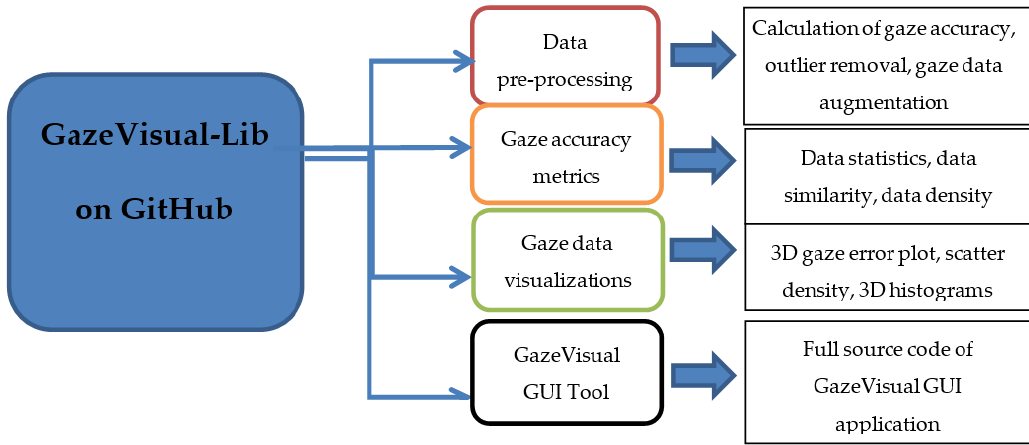
Figure 1. Organization of the GazeVisual-Lib code repository on GitHub.